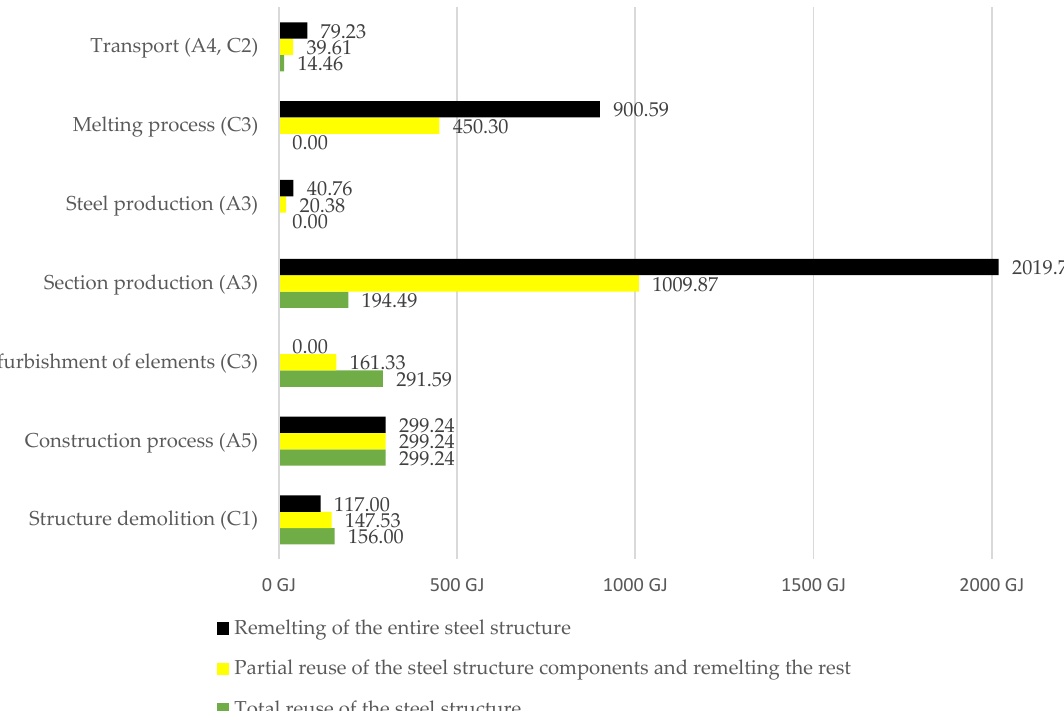
the LCA modules of the buildings according to the standard EN 15978:2011 are specified.